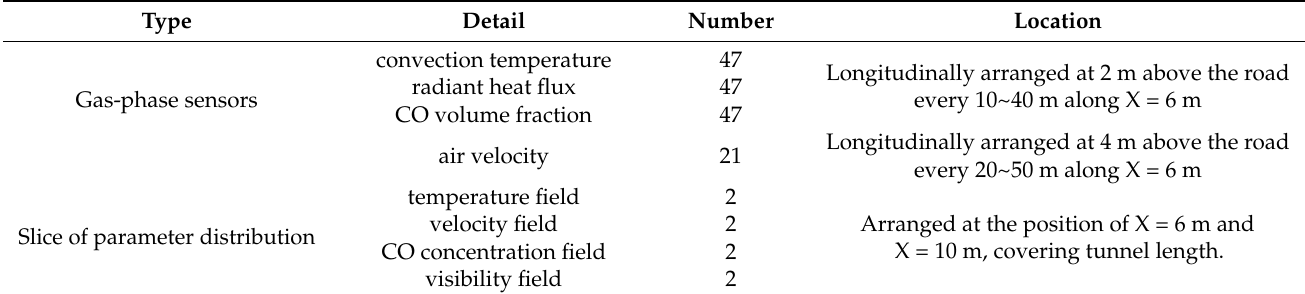
Table 4. Sensors and slice settings.